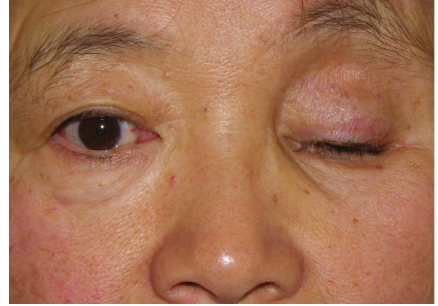
Figure 5: Preoperative view of Case